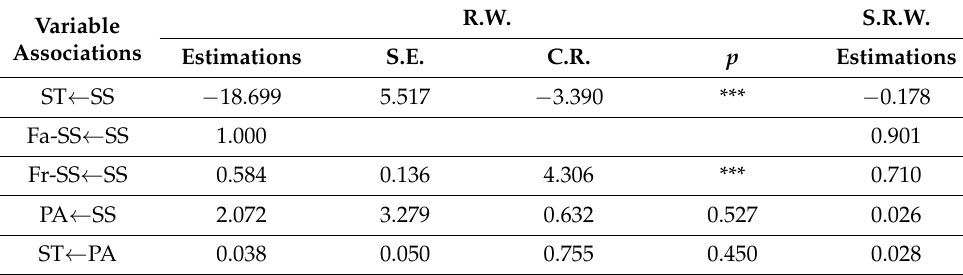
Table 2. Structural model of the theoretical model.